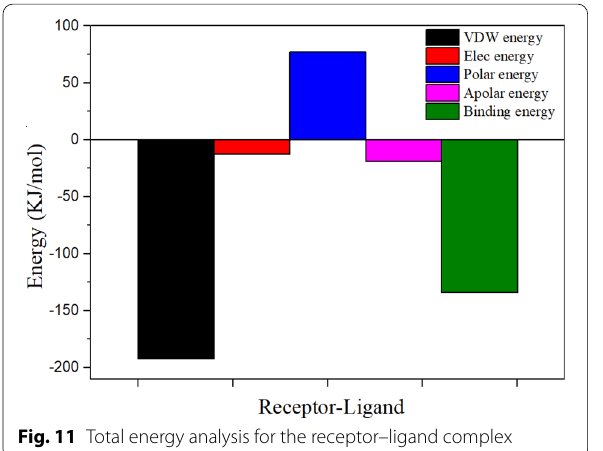
Fig. 11 Total energy analysis for the receptor–ligand complex